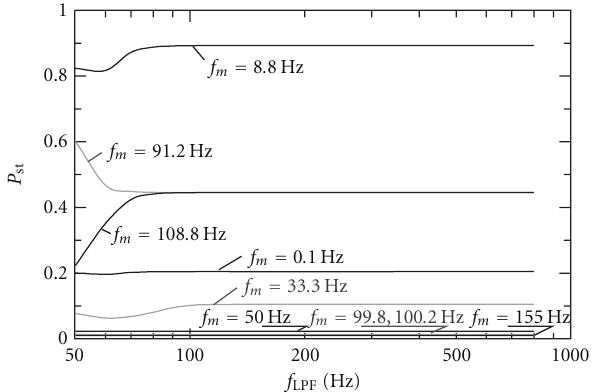
Figure 8: Plot of f LPF < 100Hz for AM modulation with rec- tangular signal.